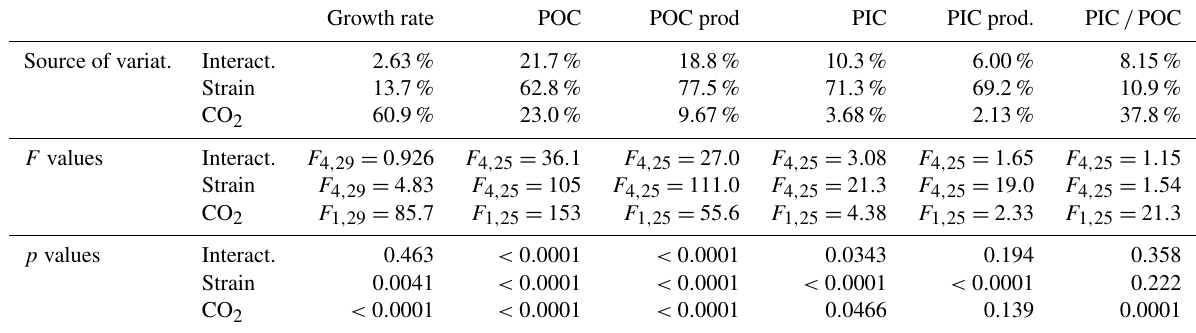
Table 3. Global two-way ANOVA results for growth and biogeochemical parameters of strains exposed to high-CO 2 –low-pH conditions vs. control CO 2 treatment. PIC / POC values were log2-transformed prior to testing.